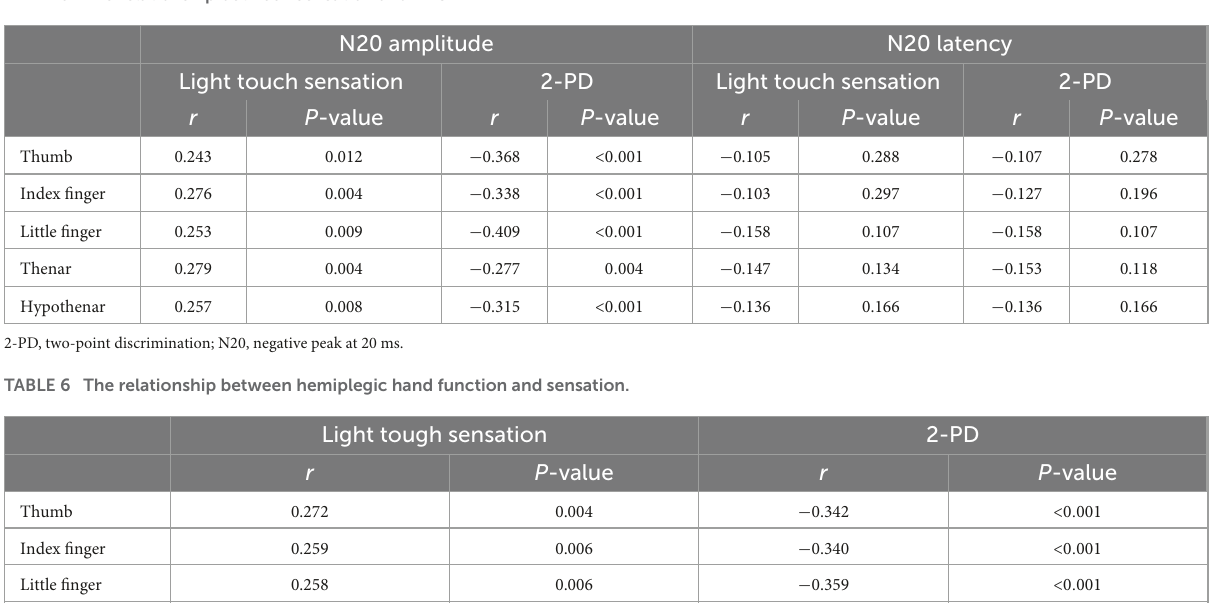
TABLE 5 The relationship between sensation and N20.